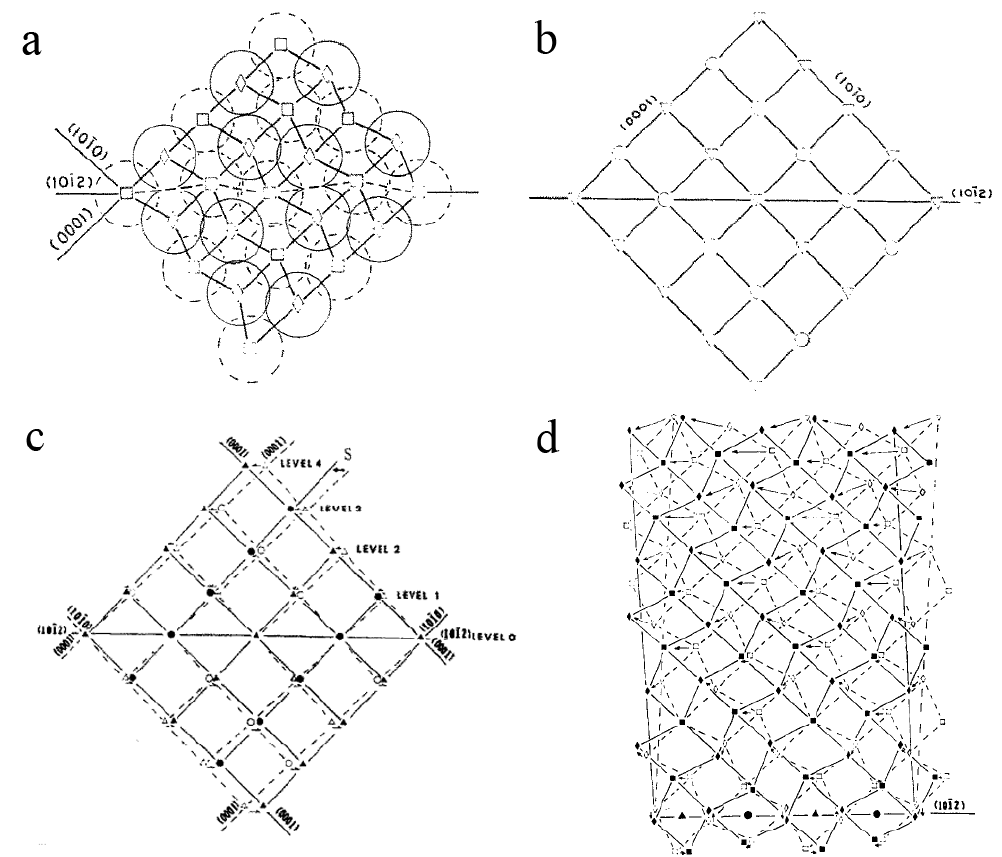
Figure 33. Kronberg’s model of extension twinning in hcp metals. ( a ) Initial crystal with the “hard-sphere” atoms projected along the [010] hex direction, ( b ) corresponding lattice, ( c ) lattice distortion during twinning, and ( d ) lattice distortion and atomic displacements during twinning. Reprinted from [154] with permission from Elsevier.